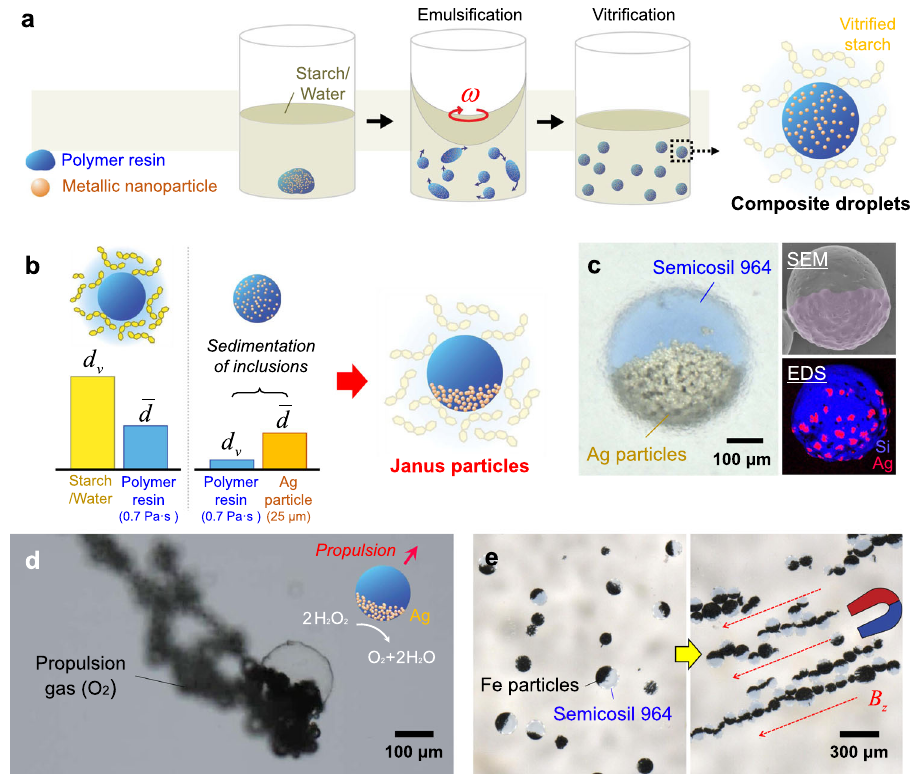
Fig. 4 Scalable programming of Janus particles. a Illustration of preparing composite droplets to program anisotropy. b Manufacturing conditions for the composite droplets to evolve as Janus particles, determined by a relation between the vitri fi cation diameter d v and the mean diameter (cid:1) d of the droplet. Polymer droplets are fi xed in a vitri fi ed starch network ( d v > (cid:1) d ) while the nanoparticle inclusions sediment ( d v < (cid:1) d ). c Optical micrograph of a Janus particle and its SEM and EDS images. The SEM image is false-colored to emphasize the presence of Ag on one side. d Self-propelling of the Janus particle in hydrogen peroxide. e Alignment of ferromagnetic Janus particles by an external magnetic fi eld, B z .